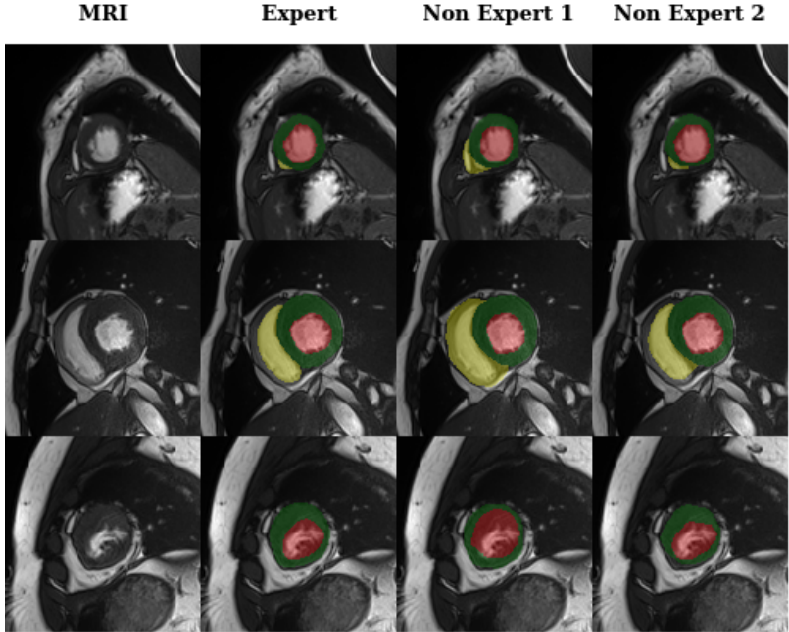
Figure 1. ACDC Annotation differences between Expert, Non-Expert 1 and Non-Expert